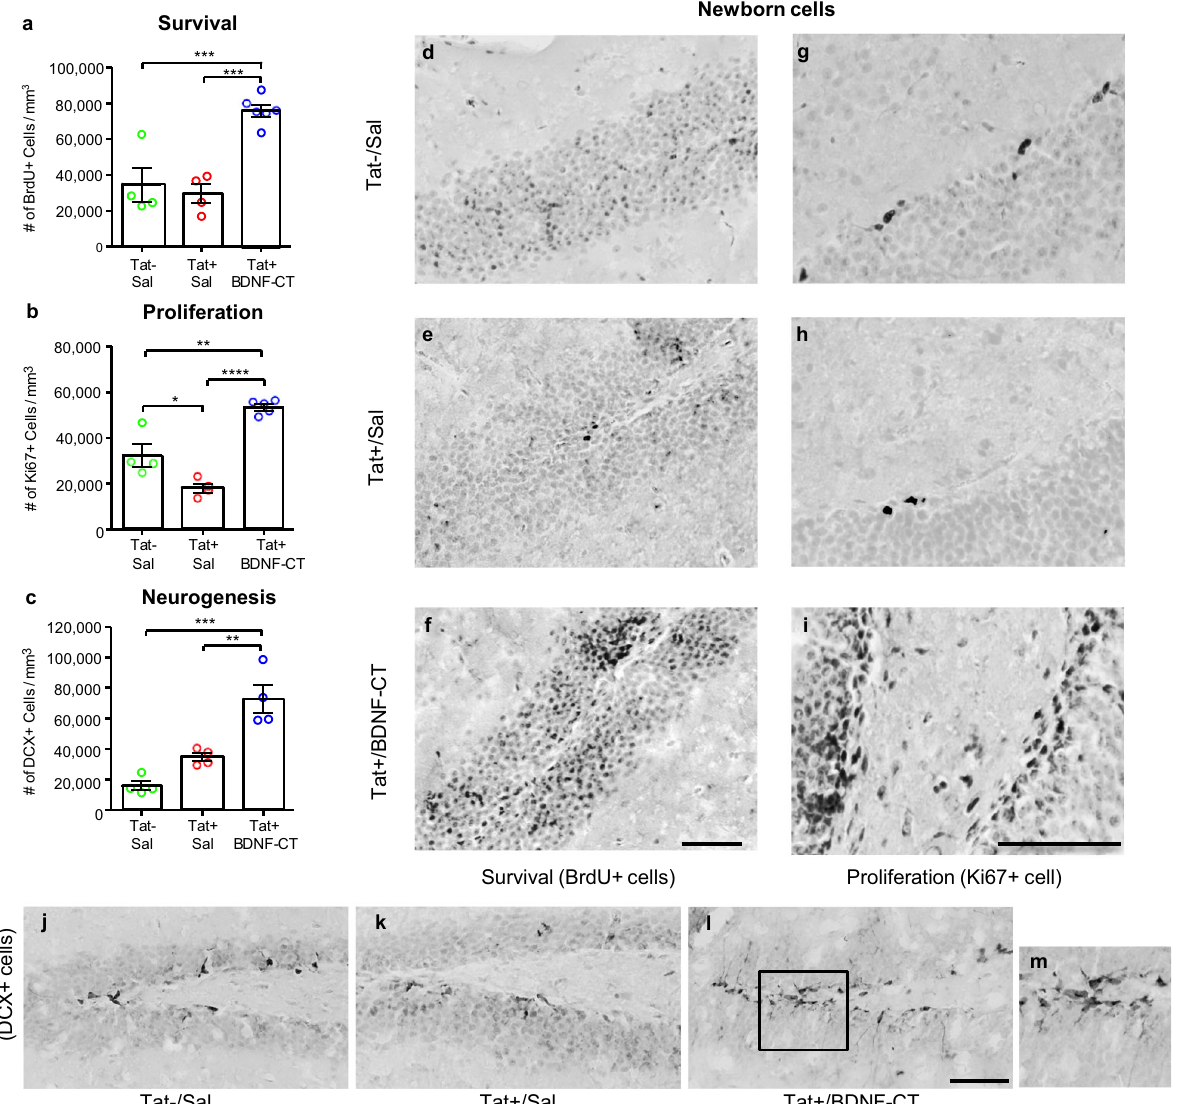
Fig. 4 BDNF-CT increased newborn cell survival, proliferation, and neurogenesis. Tat + mice received i.p. Dox (100 mg/kg) and i.n. saline or BDNF-CT (0.3 mg/kg of BDNF and 2.4 mg/kg of CT) daily for 7 days. Tat − controls received i.p. and i.n. saline. All mice received BrdU (50 mg/kg, i.p. every 12 h) on days 1 and 2 and were sacri fi ced on the 7th day. Hippocampal sections containing the granule cell layer (GLC) were evaluated for BrdU + , Ki67 + , and DCX + cells using IHC with nickel enhanced DAB staining (black). Densities of BrdU + cells ( a ), Ki67 + cells ( b ), and DCX + cells ( c ) are higher in BDNF-CT- treated Tat + mice vs. matched controls (Tat + and Tat − ) that received saline. Data are represented as the mean density. Error bars represent S.E.M. ( n = 4 – 6 per group, * P < 0.05, ** P < 0.01, *** P < 0.001, and **** P < 0.0001). Images represent BrdU + ( d – f ), Ki67 + ( g – i ) or DCX + ( j – l ) staining (black) in the hippocampal GCL following administration of Sal/Sal to Tat − mice, and Dox/Sal or Dox/BDNF-CT to Tat + mice. Higher magni fi cation of the marked area ( l ) with DCX + cells are shown ( m ). Color saturation is 0% and scale bars are 50 µ